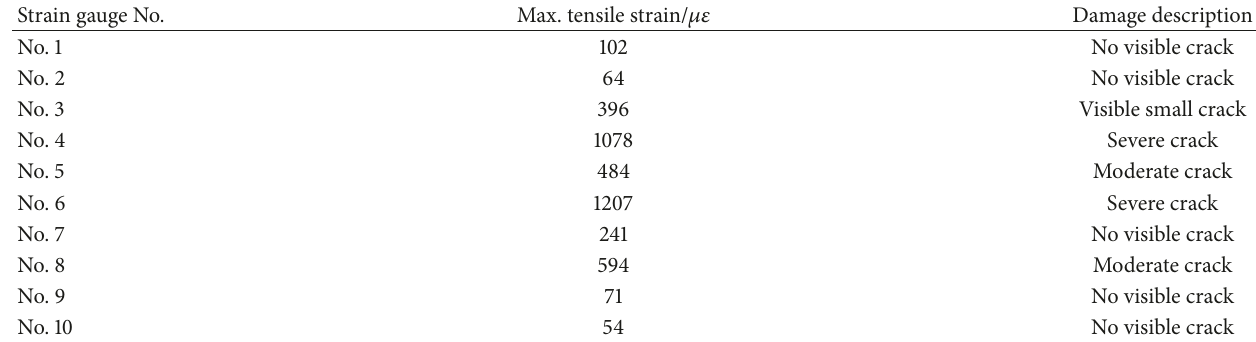
Table 9: Max. tension strains and damage description for the model in the test.